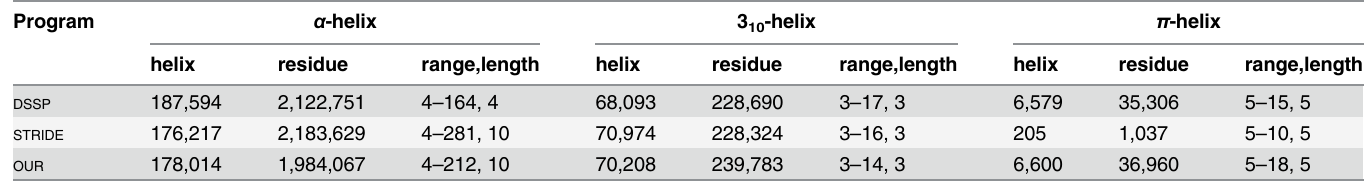
Table 3. Helix assignment on a residue and a helix basis by our algorithm, DSSP and STRIDE . The third column for each helix type presents respectively the range in helix length and the length of the most frequently appeared helices. Program